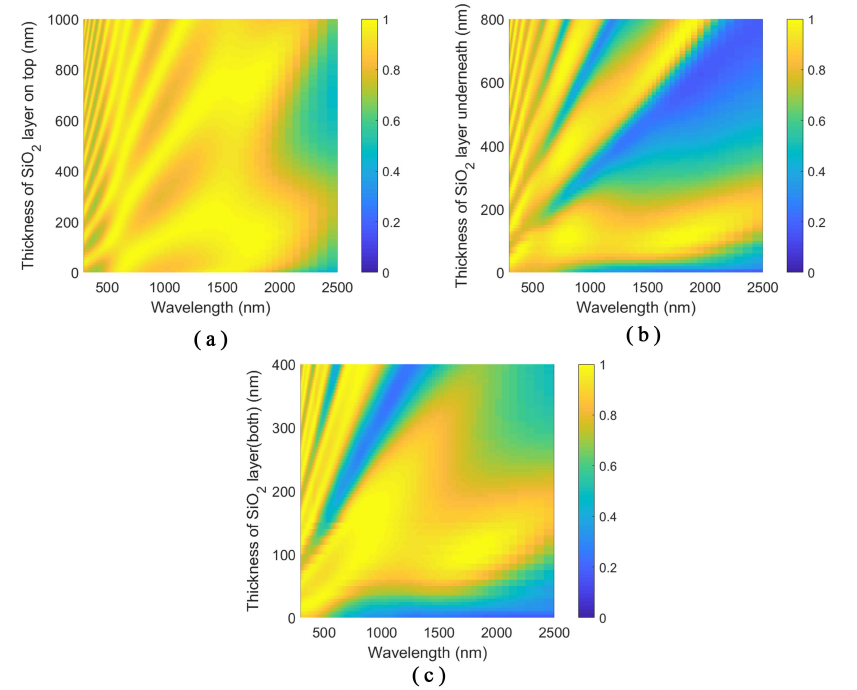
Figure 6. Absorption spectra of the SiO 2 /patterned-TiN/SiO 2 /TiN stacks with respect to: ( a ) varying the thickness of SiO 2 layer on the top; ( b ) varying the thickness of the SiO 2 layer underneath; and ( c ) varying the thickness of both SiO 2 layers in the SiO 2 /patterned-TiN/SiO 2 /TiN four layer stacks. The thickness of the patterned-TiN layer is 20